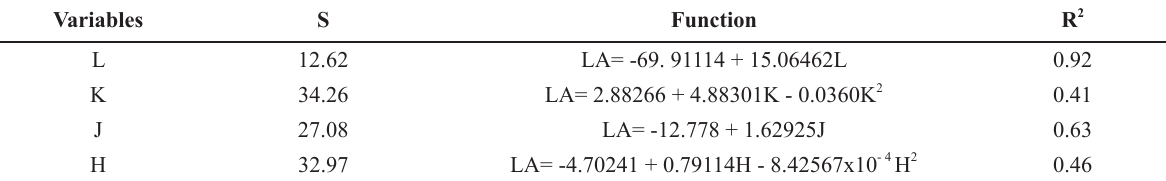
Polynomial models for estimate of the leaf area as a function of length (L) of the central lobe, the length and width product (K), length and number of lobes (J), length, width and number of lobes (H), in cassava leaves, cultivar IAC 576- 70, at 80 days after planting in the region of Botucatu, SP,